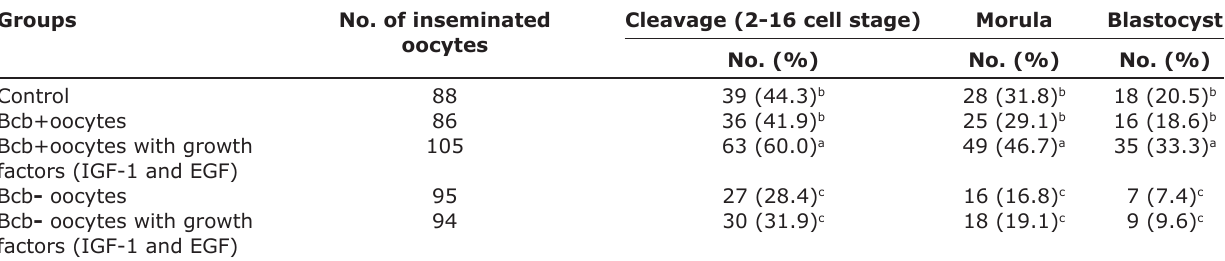
Table-3: Effect of growth factors addition during IVM of BCB selected oocytes on the percentages of cleavage, morula and blastocyst development.